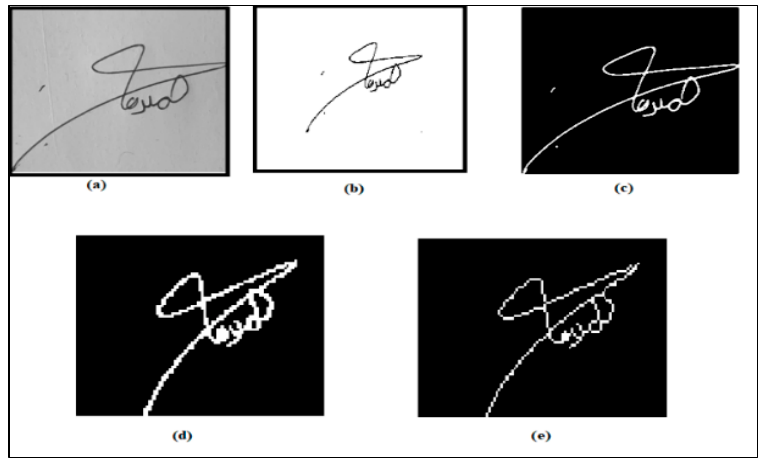
Figure 5. Locations of points that satisfy the conditions.